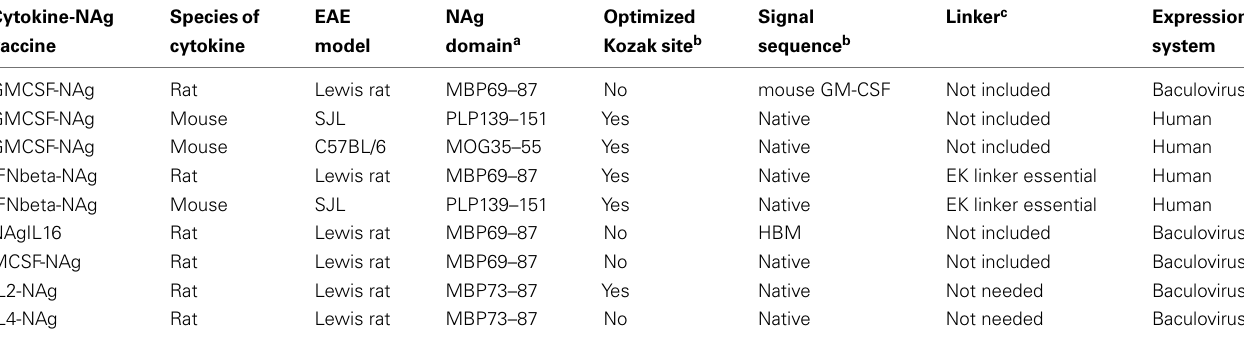
Table 1 | Selected cytokine-NAg vaccines tested for induction of tolerance in